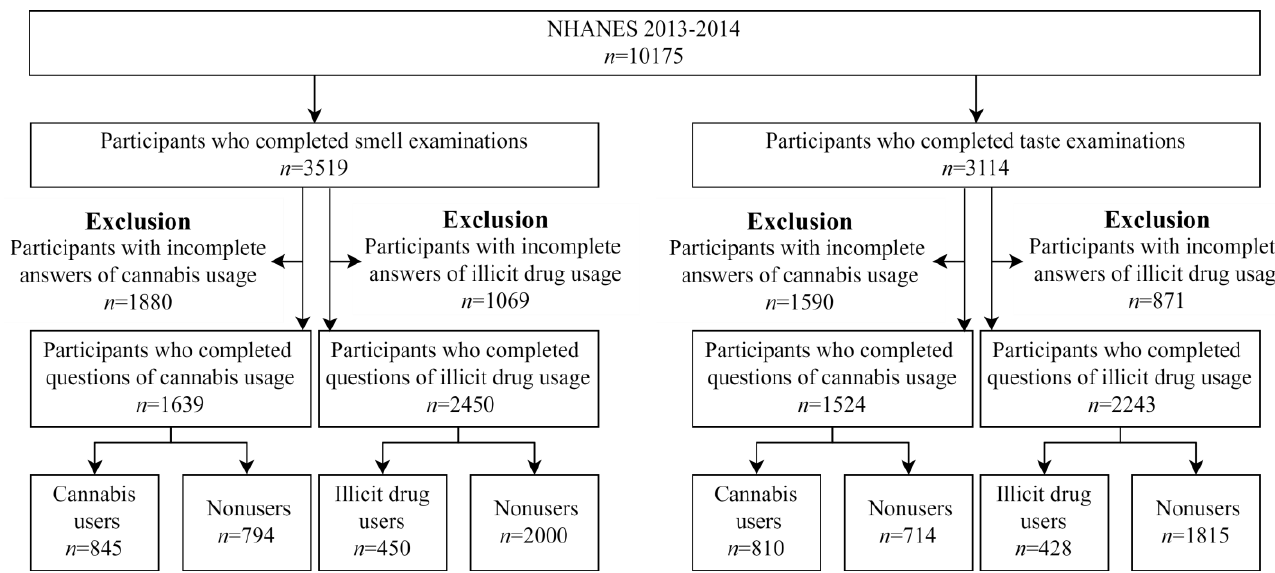
Figure 1. Flow Diagram for Study Sample Selection.